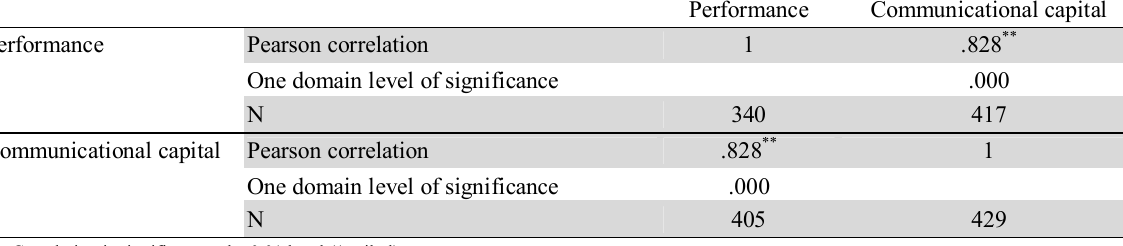
The summary of testing the second sub-hypothesis